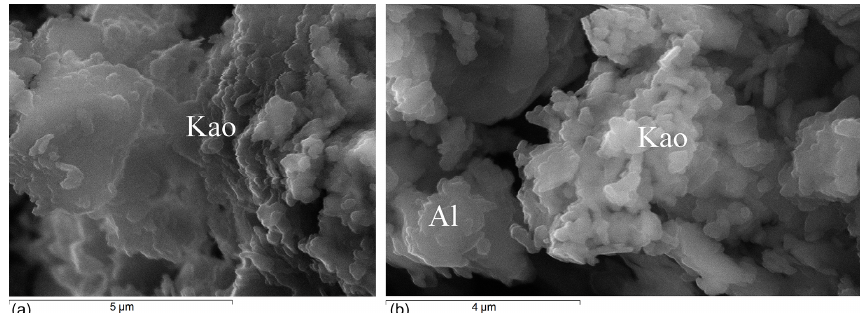
Figure 4. BSEM image of kaolinite platy crystals at the new pool of Solfatara (New P, Fig. 1c, d): the kaolinite plates have a tendency to assembly (a) and associate with alunite (b) . Kao – kaolinite; Al – alunite.